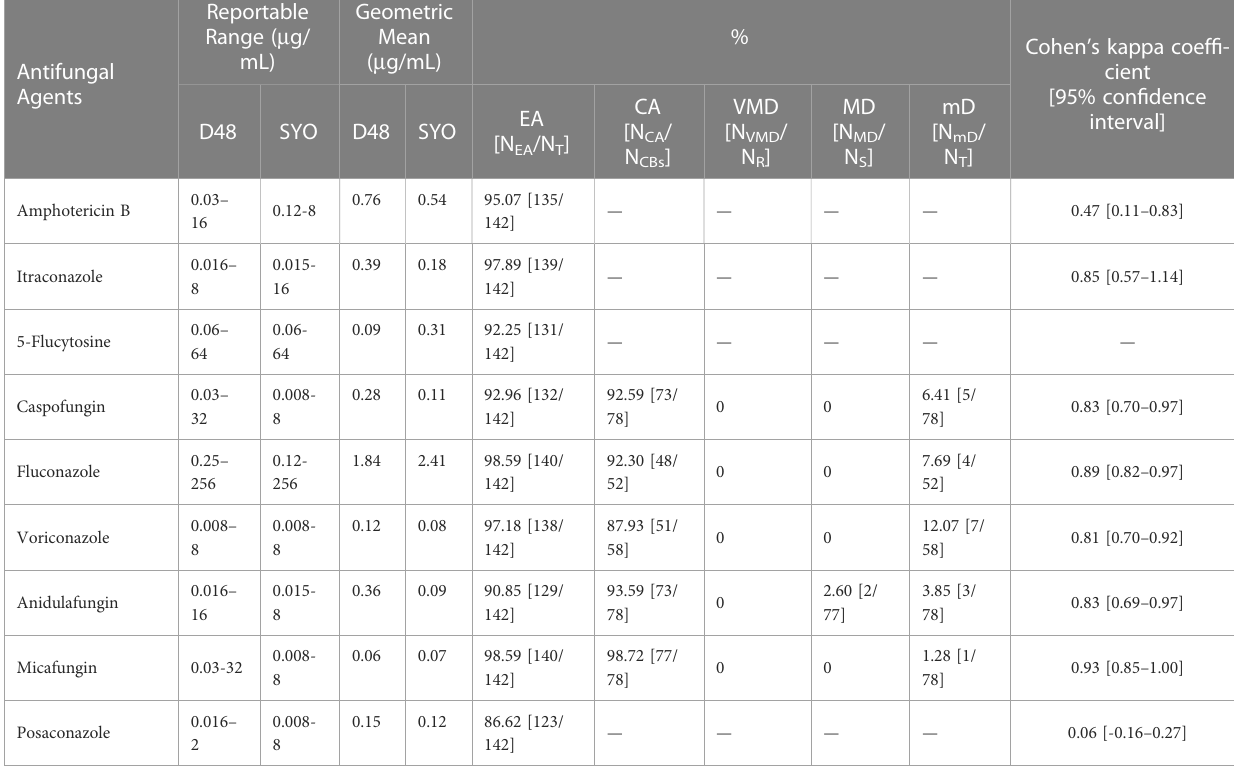
TABLE 1 Reportable range and geometric mean of antifungal agents used in this study and analysis on the agreement of D48 and SYO detection results.